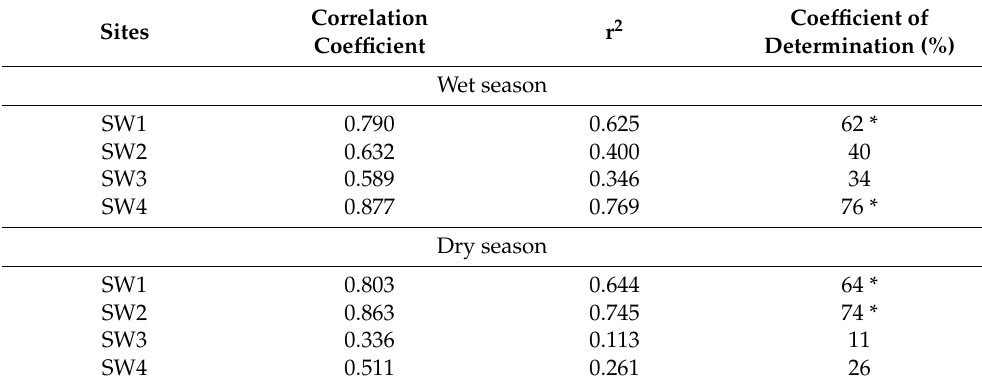
Table 3. Regression and correlation statistics between PM 2.5 (source site) and GHG along with meteorological parameters using significance level in wet